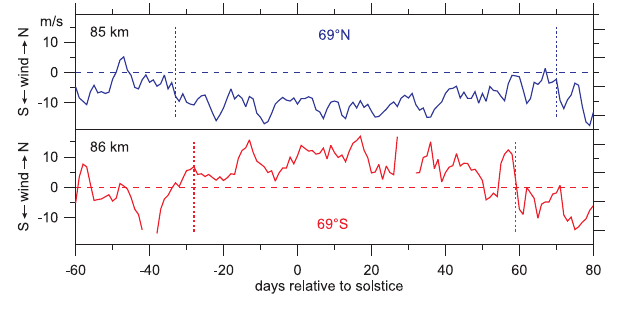
Fig. 11. Daily mean meridional winds obtained from meteor radar observations at Andenes and from MF radar observations at Davis during the boreal summer 2004 and the austral summer 2004/2005. The vertical lines indicate the occurrence of the first and last PMSE.